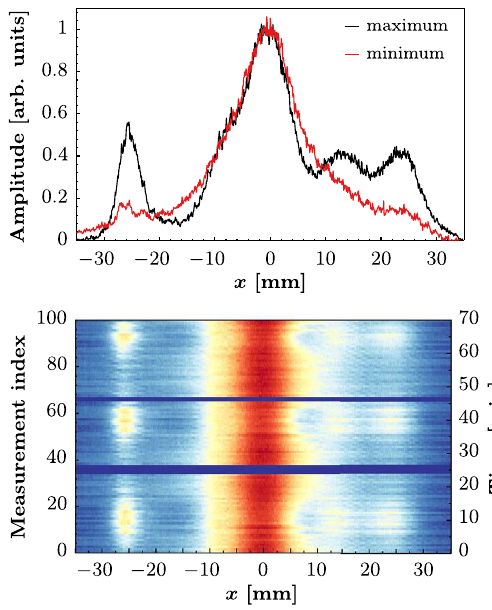
FIG. 3. Top: Comparison between good and bad splitting efficiency based on horizontal profiles measured with WS54. Bottom: Waterfall representation of multiple measured horizontal profiles, with the color scale corresponding to the amplitude of the data shown in the image at the top. Each measurement was recorded on a different cycle and clear oscillations of the beamlets ’ intensities are visible.